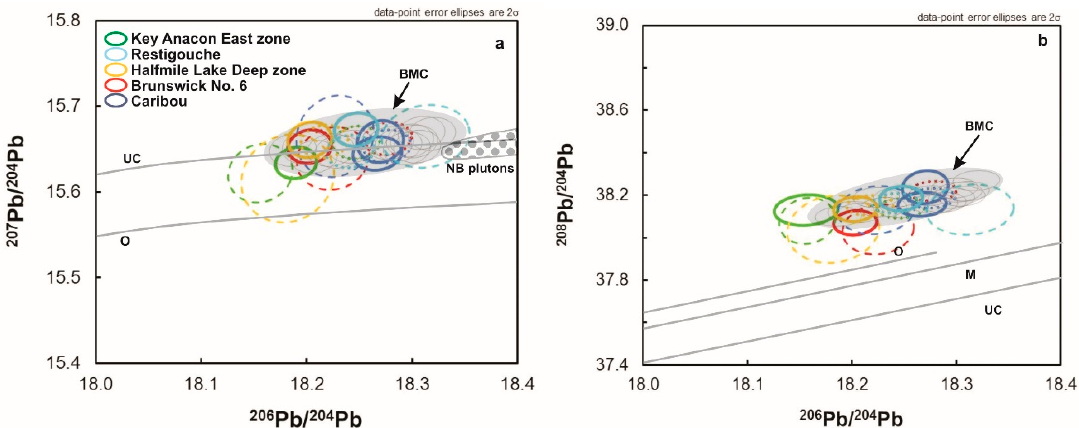
Figure 6. Plot of 206 Pb/ 204 Pb versus ( a ) 207 Pb/ 204 Pb and ( b ) 208 Pb/ 204 Pb of galena by LA-Q-ICP-MS from representative massive sulphide deposits of the BMC. The Pb isotopic ratios presented for BMC VMS (grey area) ([34–36] (R.I. Thorpe, unpublished data), [48]) and New Brunswick, Canada (NB pluton) [50]. The average Pb evolution curves for mantle (M), orogene (O), and upper crust (UC) are from [48]. Thick dashed lines present the ablation of galena under the 44 µm, 2 Hz, and 1 J·cm − 2 condition. Thick solid lines present the ablation of galena under the 60 µm, 2 Hz, and 0.35 J·cm − 2 condition. Dotted line presents the reference values of Pb isotopes of examined deposits for comparison ([34]).